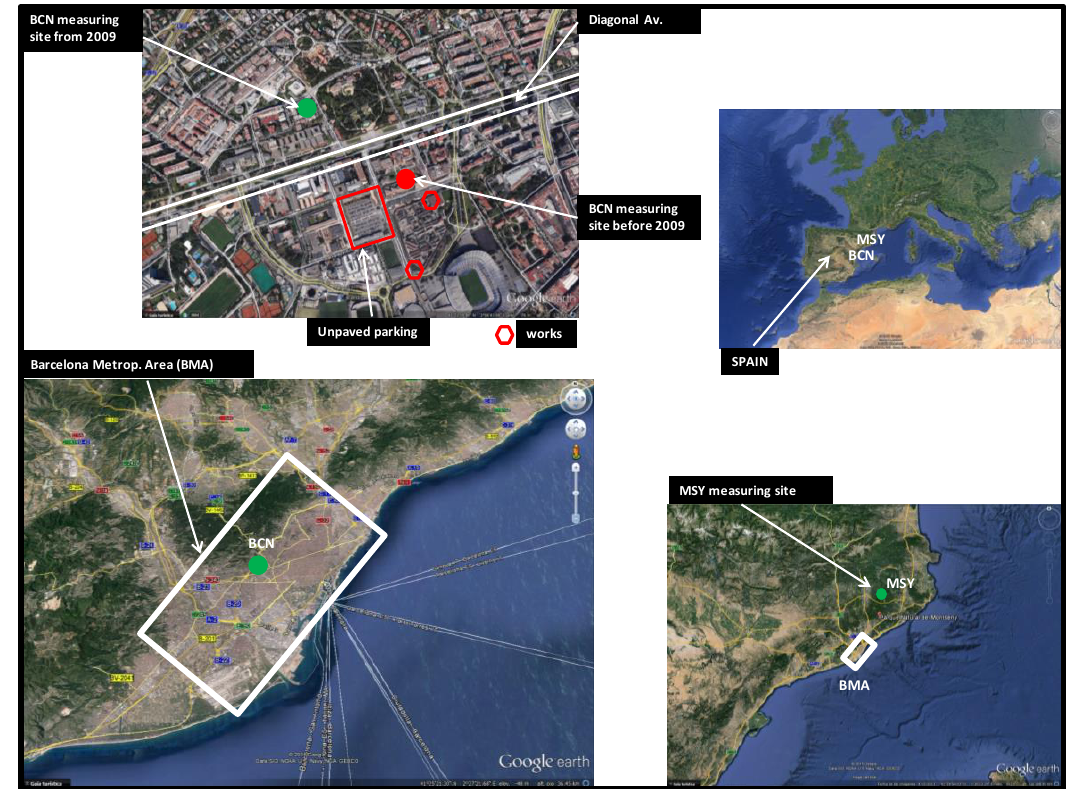
Figure 1. Location of the Barcelona (BCN) and Montseny (MSY) measuring stations. Red full circle highlights the location of the BCN Figure 1 measuring station before 2009. Green full circle highlights the new location of the BCN (from 2009) and MSY measuring